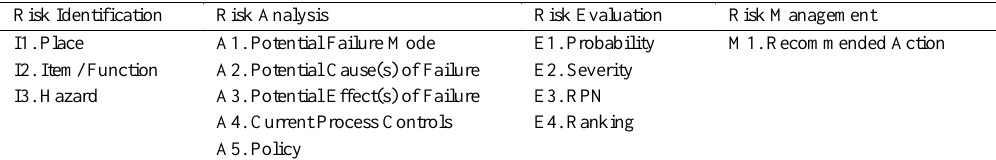
Table 2: FMEA Worksheet